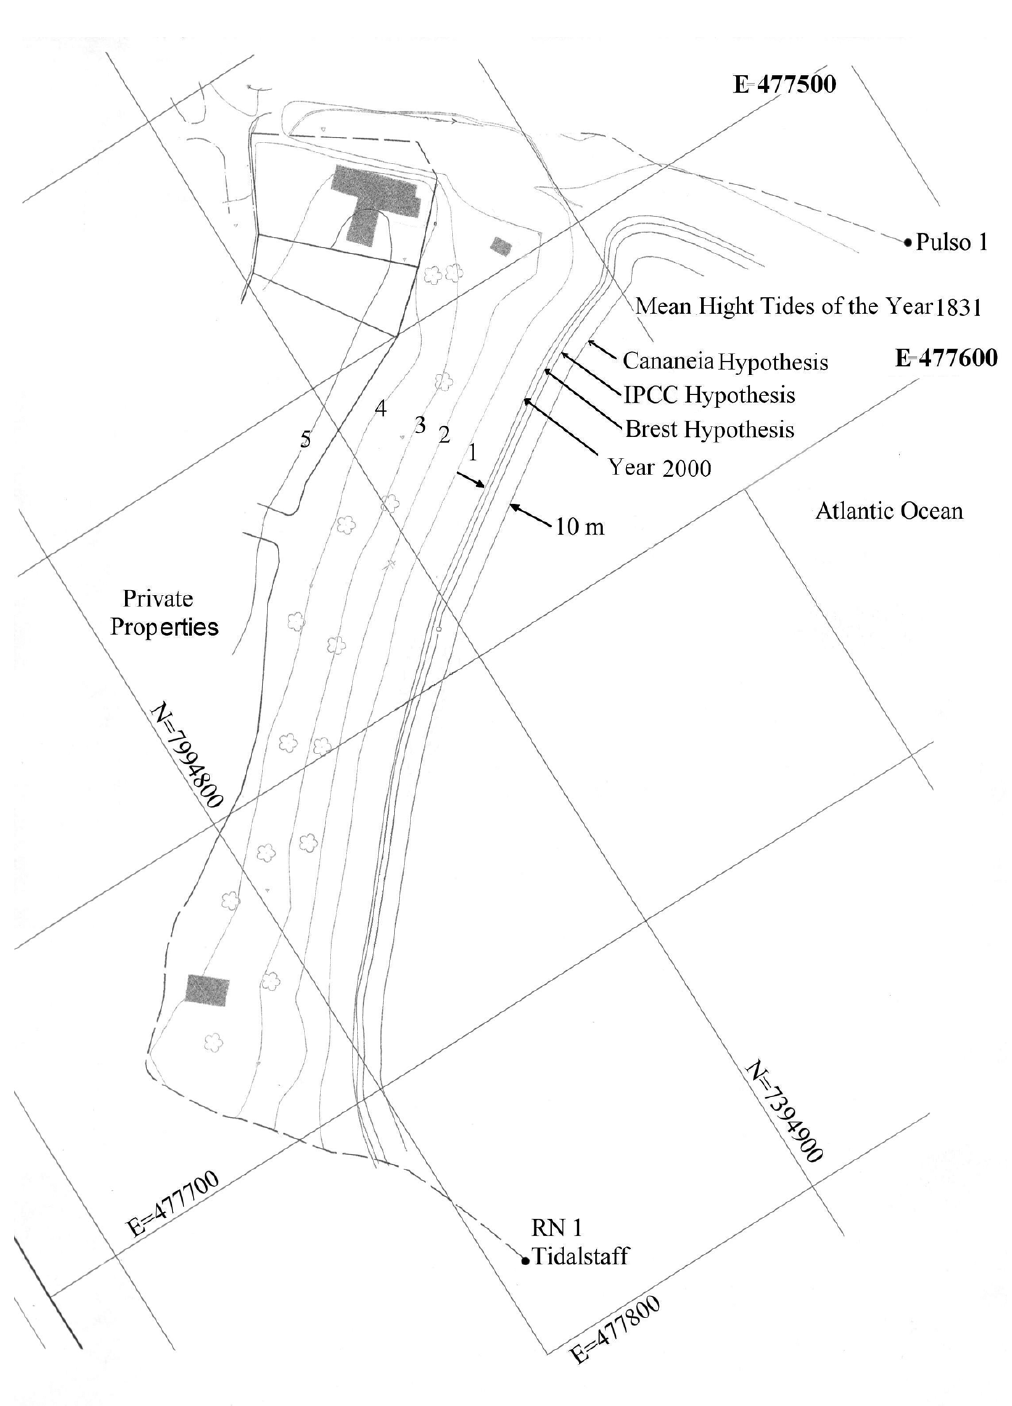
Fig. 4 – Mean Sea Level High Water (MHW) of “Praia do Pulso” (PP), of years 2000 and 1831, calculated according to the hypotheses: Brest, IPCC and Cananeia. The line of (MHW) of 2000 was obtained from the measurements at Ubatuba station, and the 1831 corresponding lines were drawn according to the hypotheses of Brest, Cananeia and IPCC. The horizontal distance among the external lines (Cananeia and Praia do Pulso 2000) of the set is nearly 10 m. From this estimate, one sees that, by taking any of the lines for the mean level of (MHW) to start measuring 33 m horizontally towards the continent, from none of them the private properties are reached. The “Terrenos de Marinha” are totally along the beach.